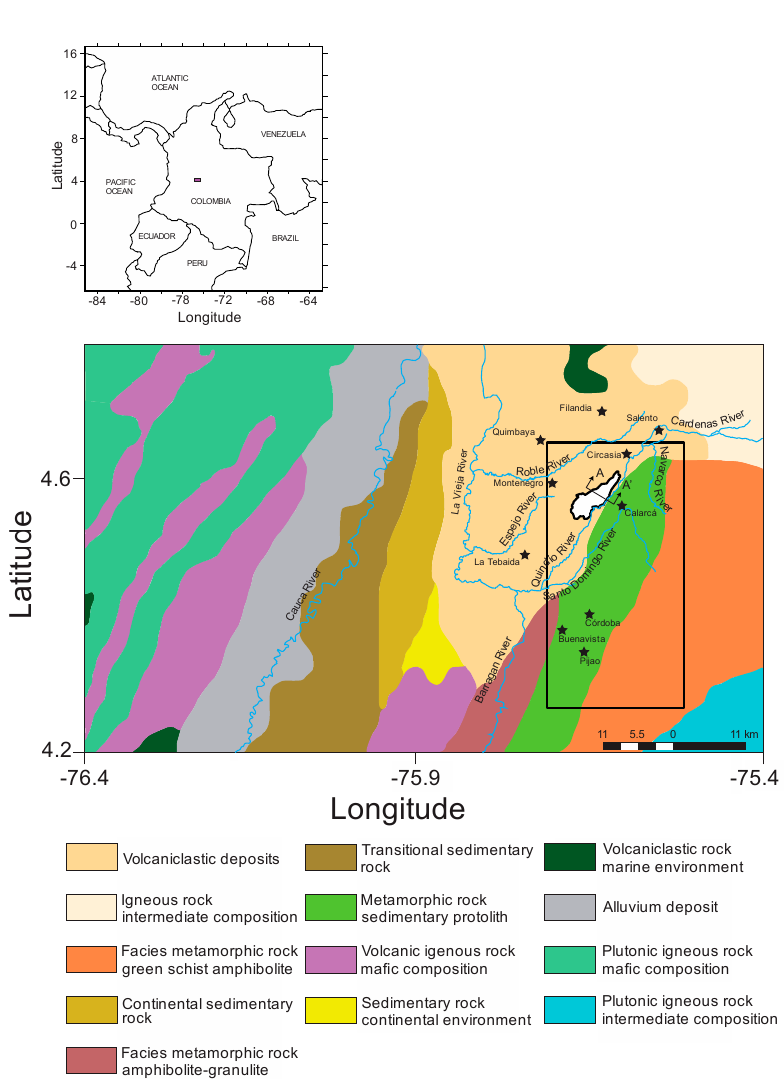
Figure 1. Upper left: Location of Armenia in Colombia, South America. The rectangle indicates the area plotted in the main figure. The main figure shows the geological map of the region around the city of Armenia (the white irregular shape indicates the extension of the city). The main rivers are shown as a reference. Geological formations include volcanic, sedimentary, and metamorphic rocks. Black stars indicate the location of towns around Armenia. The line, AA’, indicates the location of the geological cross-section shown in Figure 2. The solid rectangle indicates the area plotted in Figure 3.